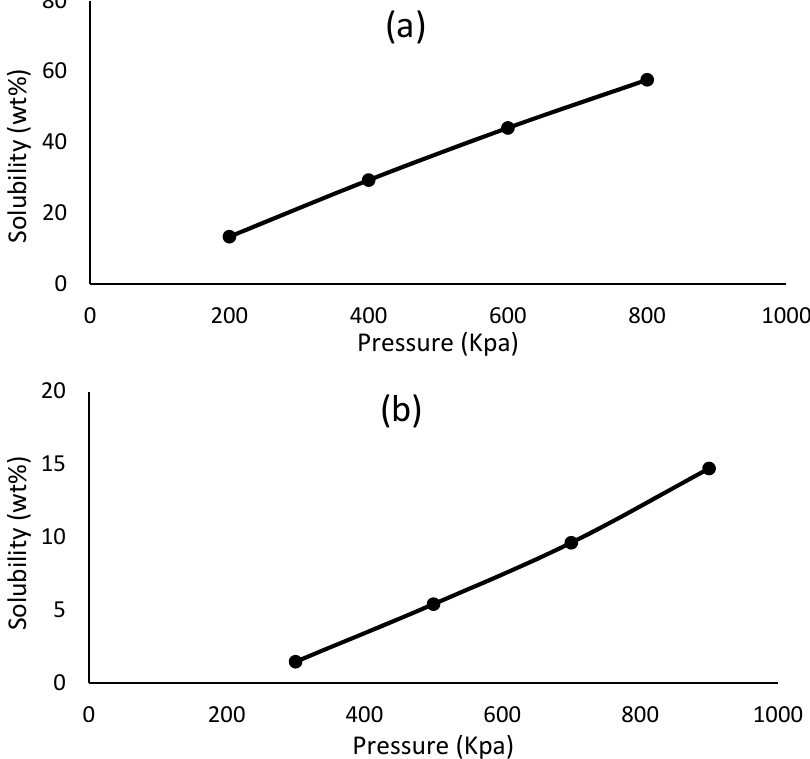
Figure 6. Solubility measurements of C 3 ( a ) and CO 2 ( b ) in the heavy oil sample.